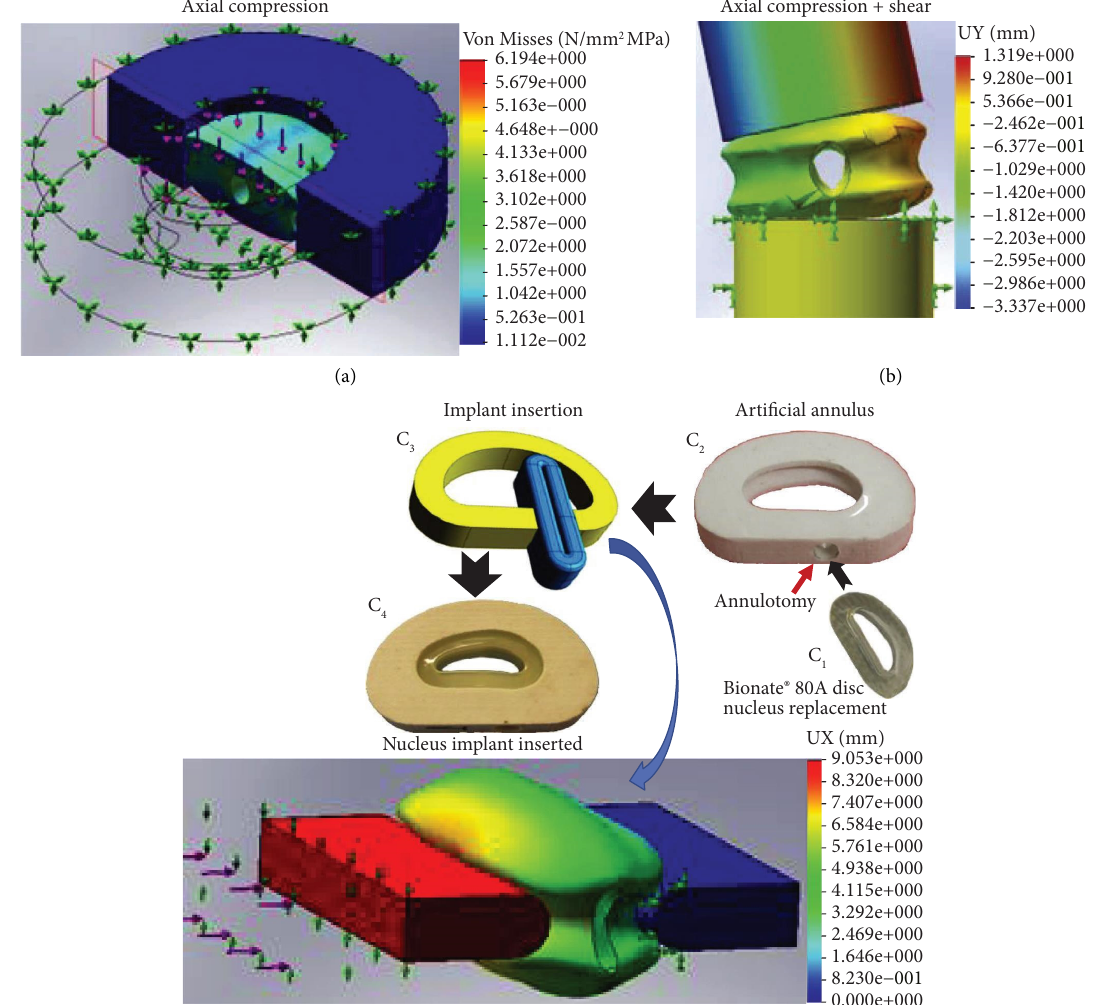
Figure 4: Selected monobloc elastomeric device FEA studies during (a) axial compression, (b) lateral compression, and (c) axial com- pression plus shear. Implant deformations in the x (UX) and y (UY)